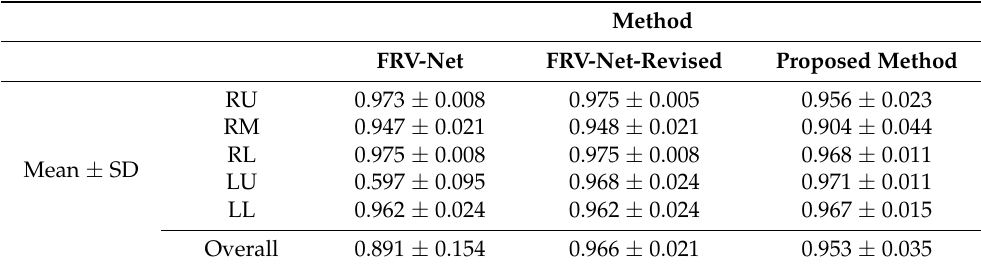
Table 3. Quantitative summary of the dice coefficient for the lobe segmentation methods. RU: right upper lobe, RM: right middle lobe, RL: right lower lobe, LU: left upper lobe, LL: left lower lobe, SD: standard deviation. Method FRV-Net